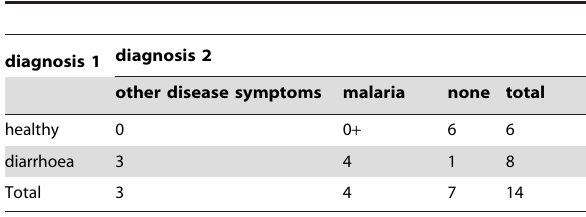
Table 3. Categorisation of the patient population by diagnostic